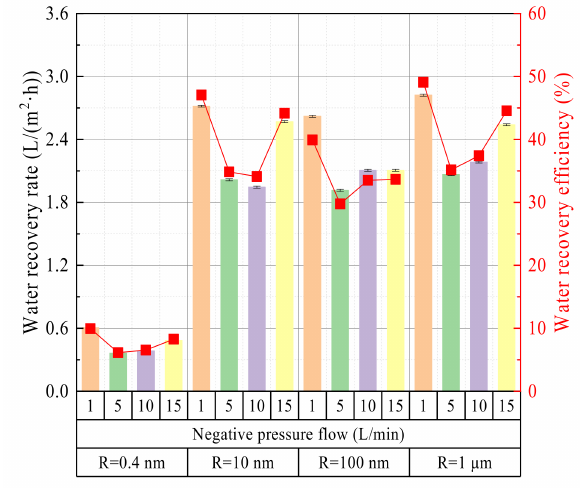
Figure 15. Water recovery rate/efficiency vs. Negative pressure airflow. Experiment conditions: flue 12.68 ◦ C.